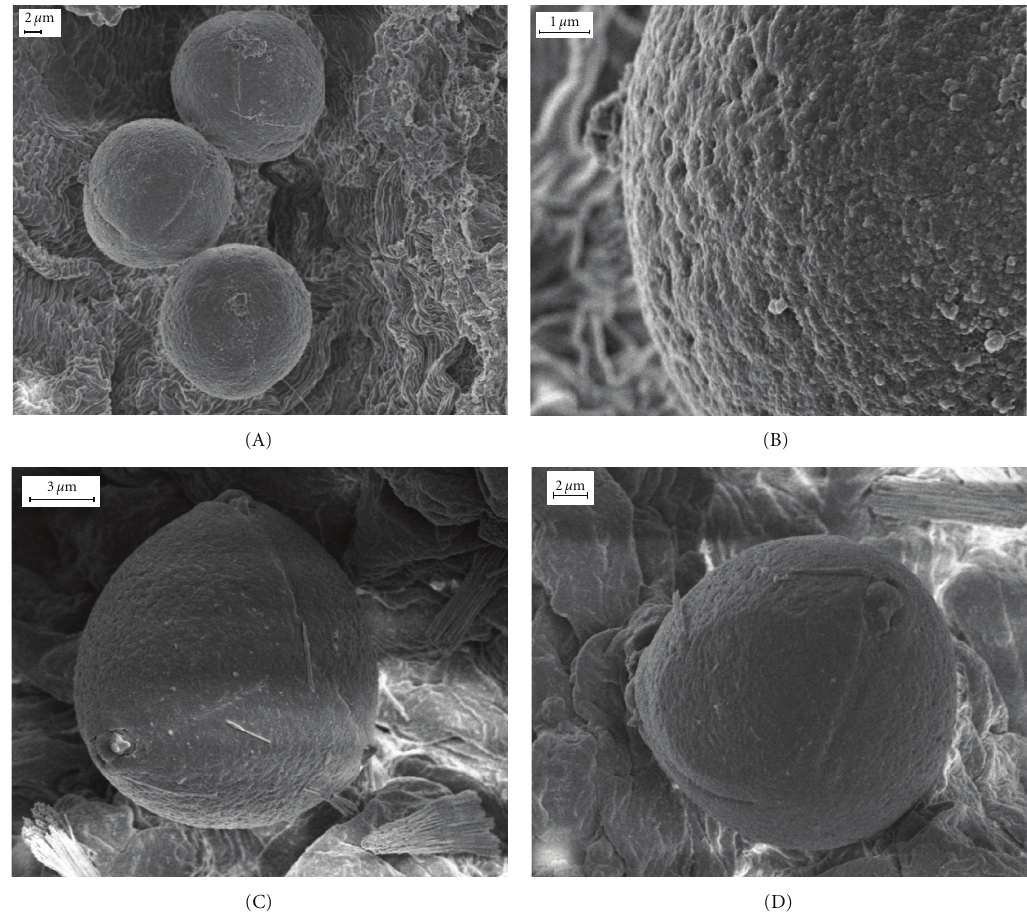
Figure 6: Stage 5: mature pollen grains. (A)-(B) Colletia paradoxa . (C)-(D) Discaria americana . (A) General view of pollen grains. (B) Details of a pollen grain. (C) Polar view of a pollen grain. (D) Equatorial view of a pollen